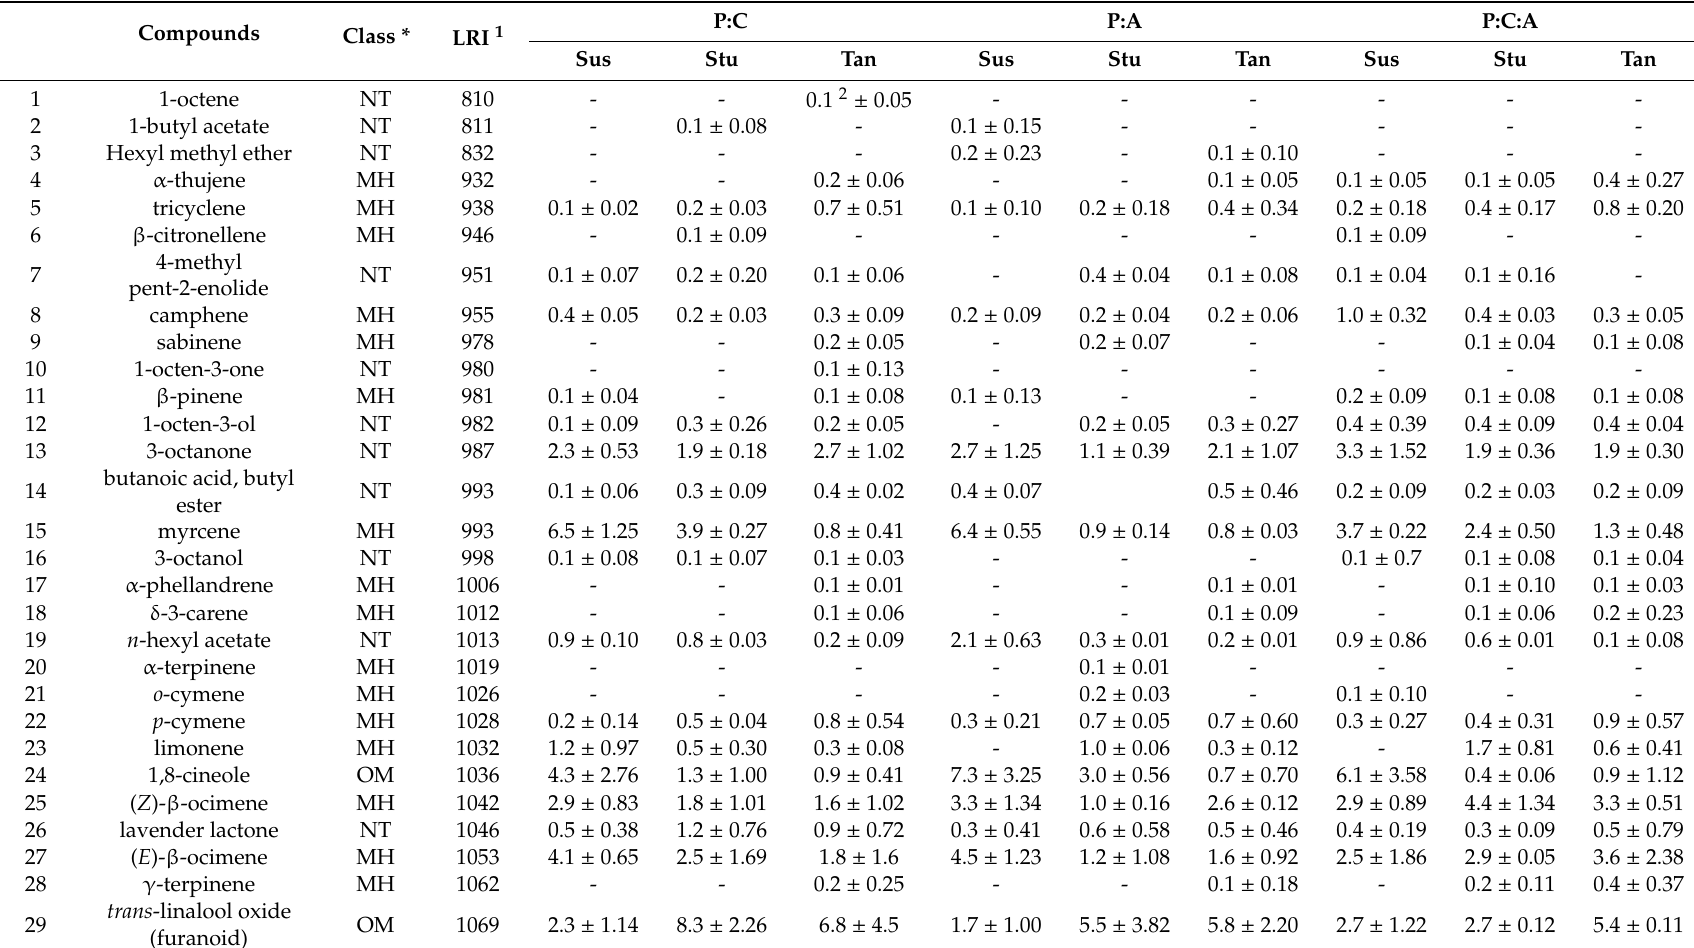
Table 3. Solid phase microextraction (SPME) volatile profiles (%) of lavender selections from Susa (Sus), Stura (Stu) and Tanaro (Tan) valleys, grown in di ff erent substrates (P:C = peat and green compost, 70%:30% v / v ; P:A = peat and demolition aggregates, 70%:30% v / v ; P:C:A = peat, green compost and demolition aggregates, 40%:30%:30% v / v ) with standard